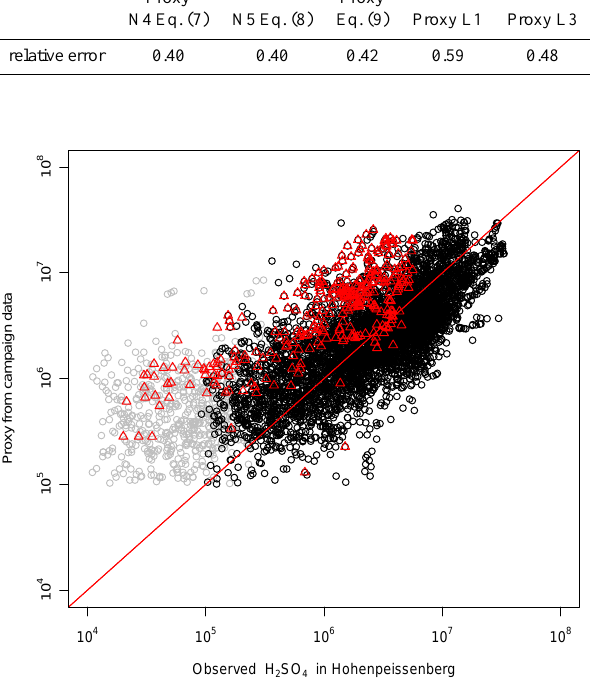
Fig. 7. Observed [H 2 SO 4 ] in Hohenpeisenberg vs. predicted values given by Proxy N5. Observations where Radiation < 50 W m − 2 are plotted grey and observations from winter months are marked with red